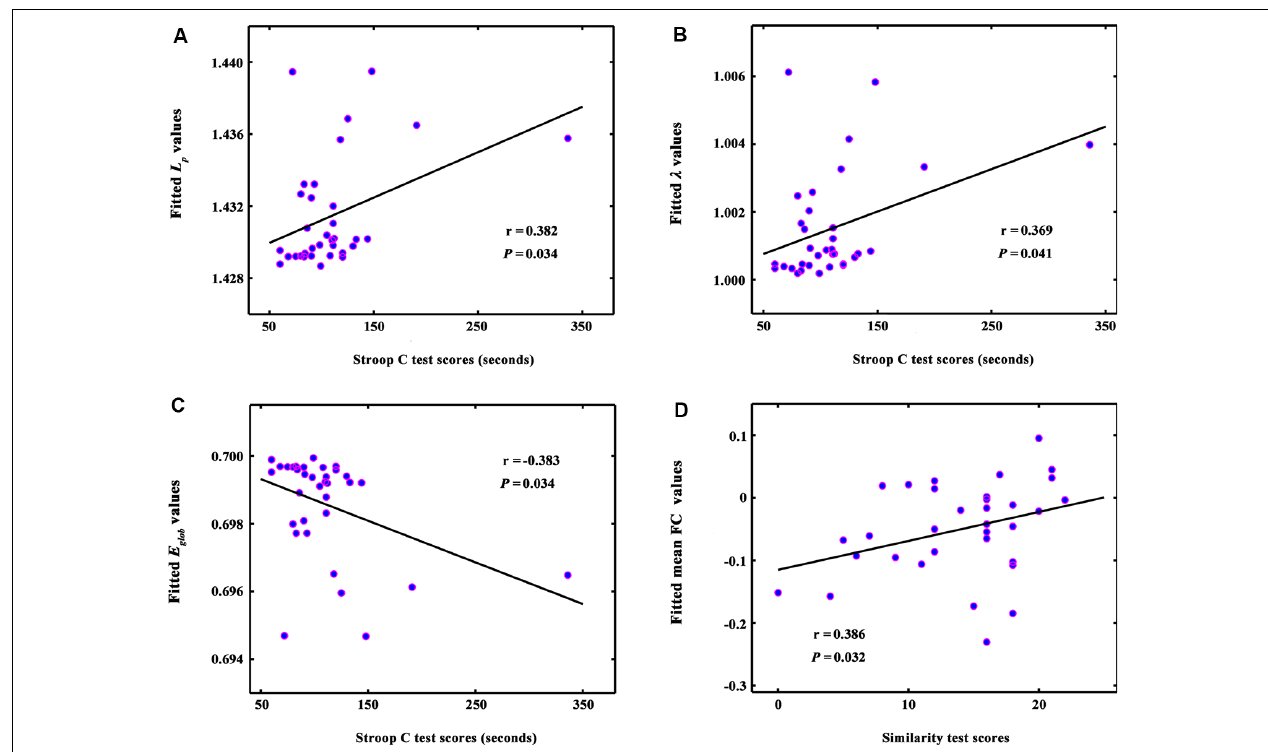
FIGURE 3 | The correlations between global network metrics and cognitive performance in ILA patients. (A–C) Within the ILA group, the whole-brain topology (i.e., L p , λ , and E glob ) correlated significantly with the Stroop C scores ( P s < 0.05). (D) The mean functional connectivity strength of the NBS-based connected network exhibited a positive correlation with the Similarity scores ( r = 0.386, P = 0.032). ILA, ischemic leukoaraiosis; NBS, network-based statistic analysis; Stroop C, Stroop color-word test C; Similarity, semantic similarity test.